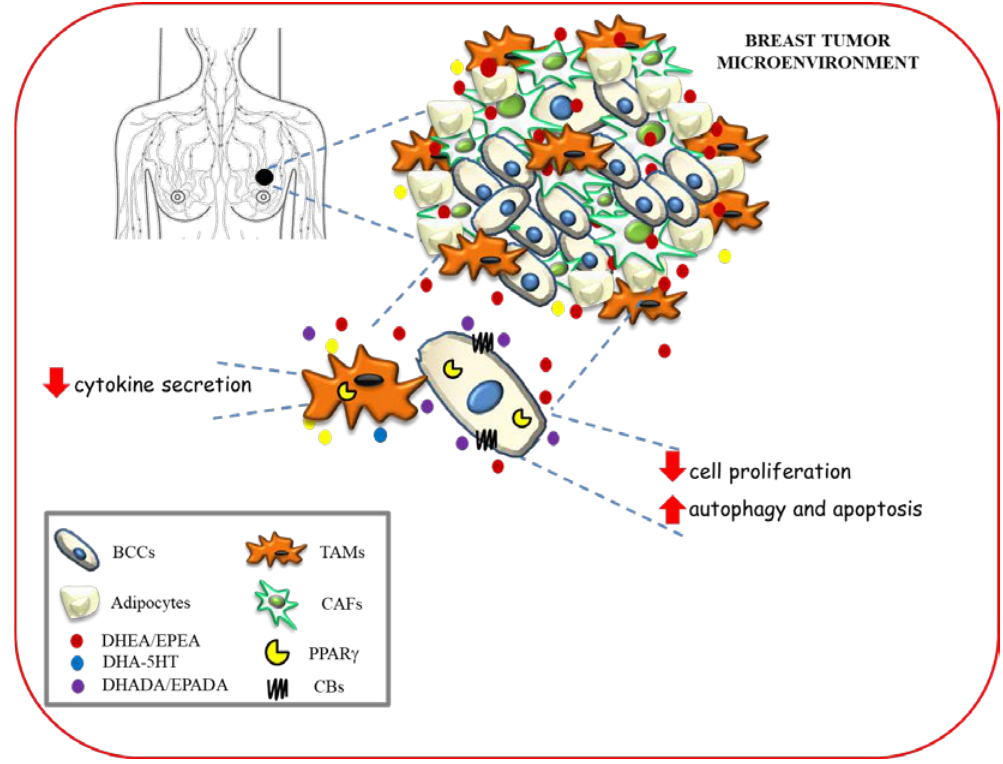
Figure 4. Hypothetical scheme showing multiple modes of action of n − 3 PUFA amides in modulating breast cancer development and progression within tumor microenvironment. BCC: breast cancer cells; TAMs: tumor associated macrophages; CAFs: cancer associated fibroblasts.